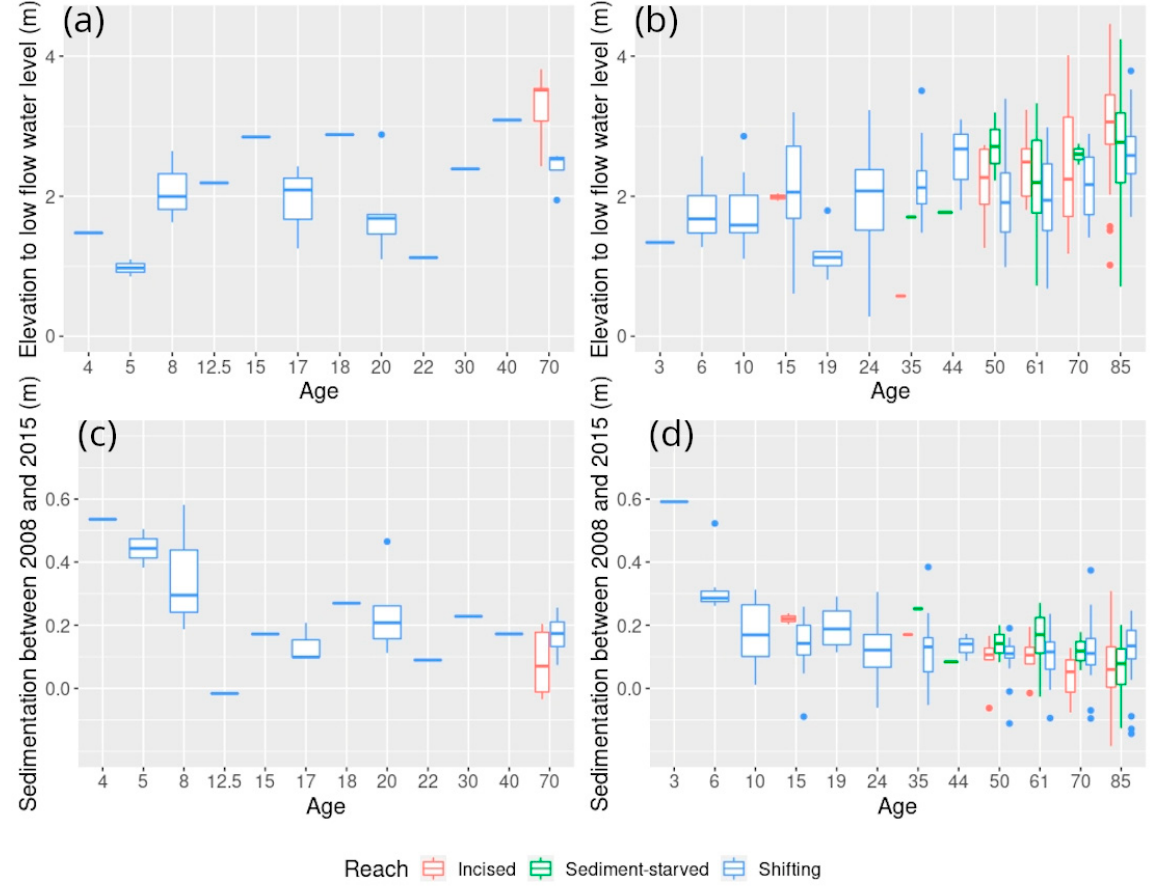
Figure 5. Elevation of reach types, relative to low-flow water level and according to age for EVS plots ( a ) and ONF plots ( b ), and overbank sedimentation of reach types between 2008 and 2015 according to the age of EVS plots ( c ) and ONF plots ( d ).